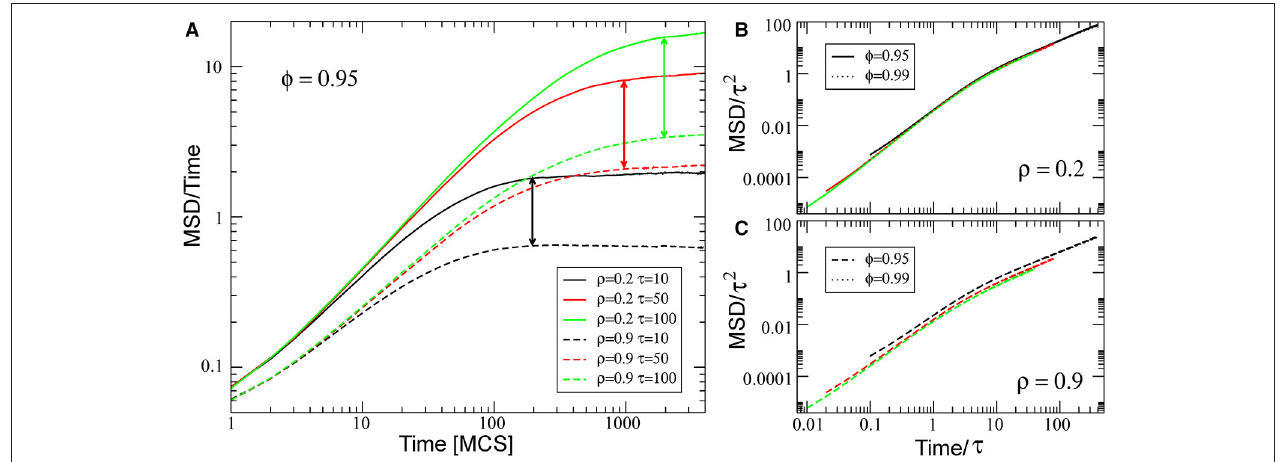
FIGURE 7 | (A) Log-log plot of the scaled mean-squared displacement vs. time t , for three different values of τ , φ = 0.95 and for two different densities: ρ = 0.2 (solid lines) and ρ = 0.9 (dashed lines). Vertical arrows mark the transition between ballistic and random walk behavior. (B,C) shows the collapse of the curves by rescaling the horizontal axes by τ and vertical axes by τ 2 , for the simulations at low and high density, respectively. All other parameters values are the same as for Figure 2 .